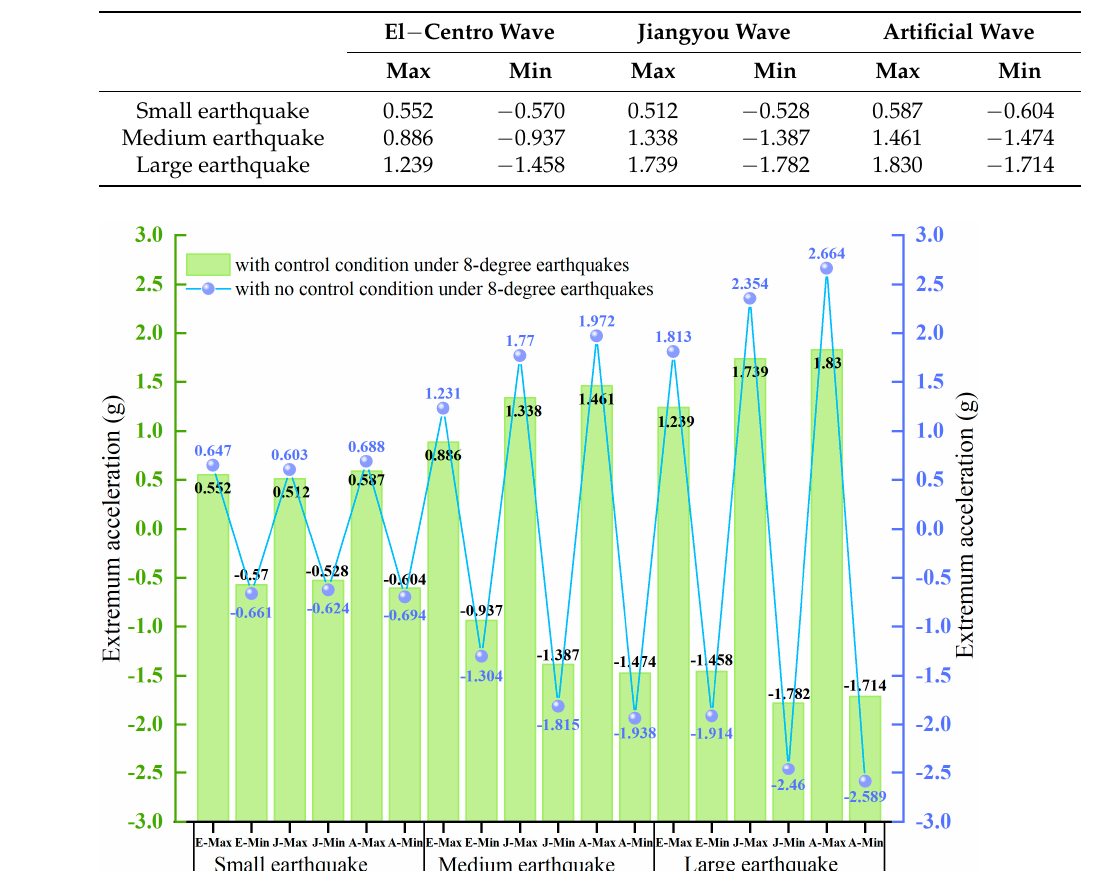
Table 5. The maximum relative displacement of the top floor of the tower with no control condition under 8-degree earthquakes (mm).